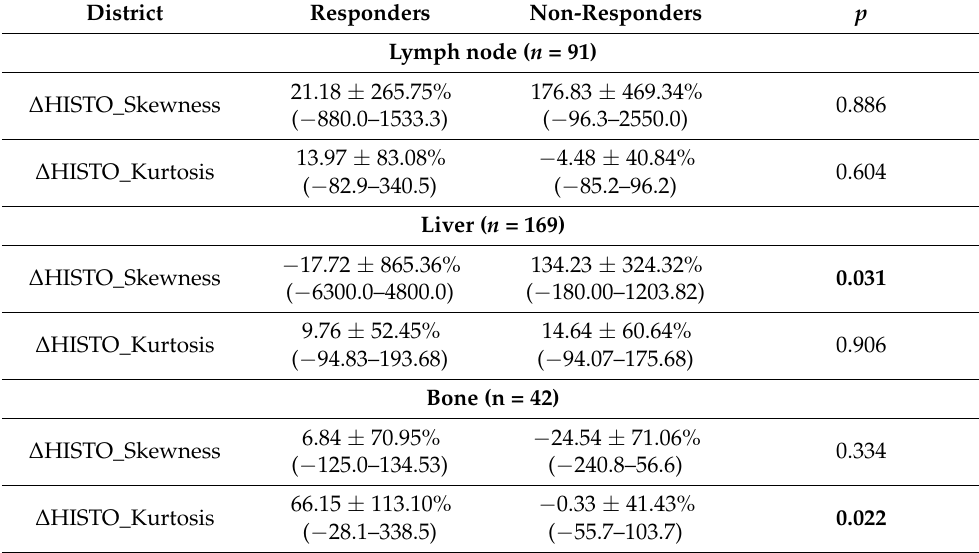
Table 3. The values of ∆ HISTO_Skewness and ∆ HISTO_Kurtosis (median ± DS, range) for PRRT responder and non-responder lesions in the three main districts affected by the